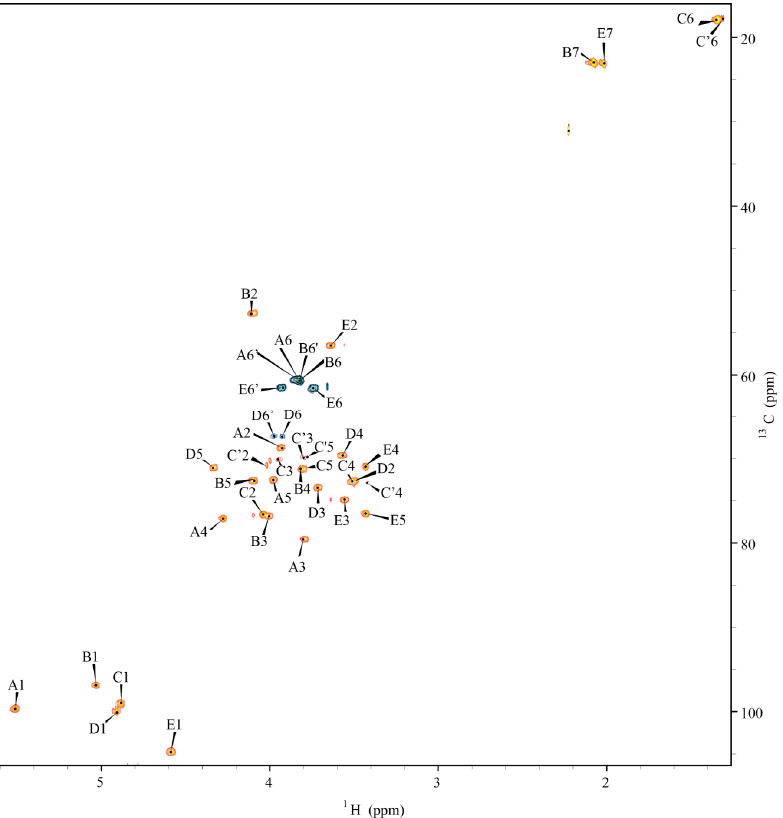
Figure 3. 1 H, 13 C HSQC-DEPT spectrum of the O-PS I of B. holmesii ATCC 51541. The capital letters refer to carbohydrate residues as shown on the structure, and the numbers refer to protons in respective residues. Table 1. 1 H and 13 C NMR chemical shifts of the O-PS of B. holmesii strain ATCC 51541 a .